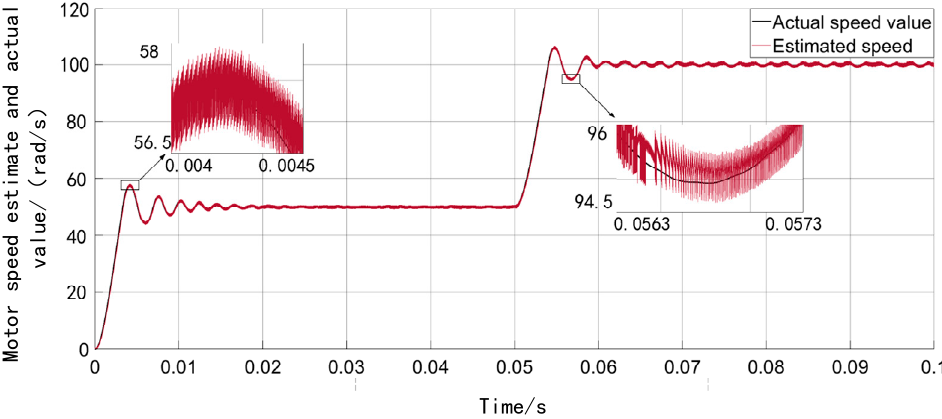
Figure 2. SMO Comparison of the motor speed of the traditional SMO observer at high speed. In Figure 2, when the red curve tracks the black curve, there are obvious burr and chat- ter in the red curve. This shows that traditional SMO has a large high frequency chattering phenomenon in the high-speed operation of the system due to the traditional SMO apply- ing the sign function as the control function of the system. Because of the sudden change of the sign function at the zero point, the system appears as high-frequency chattering.